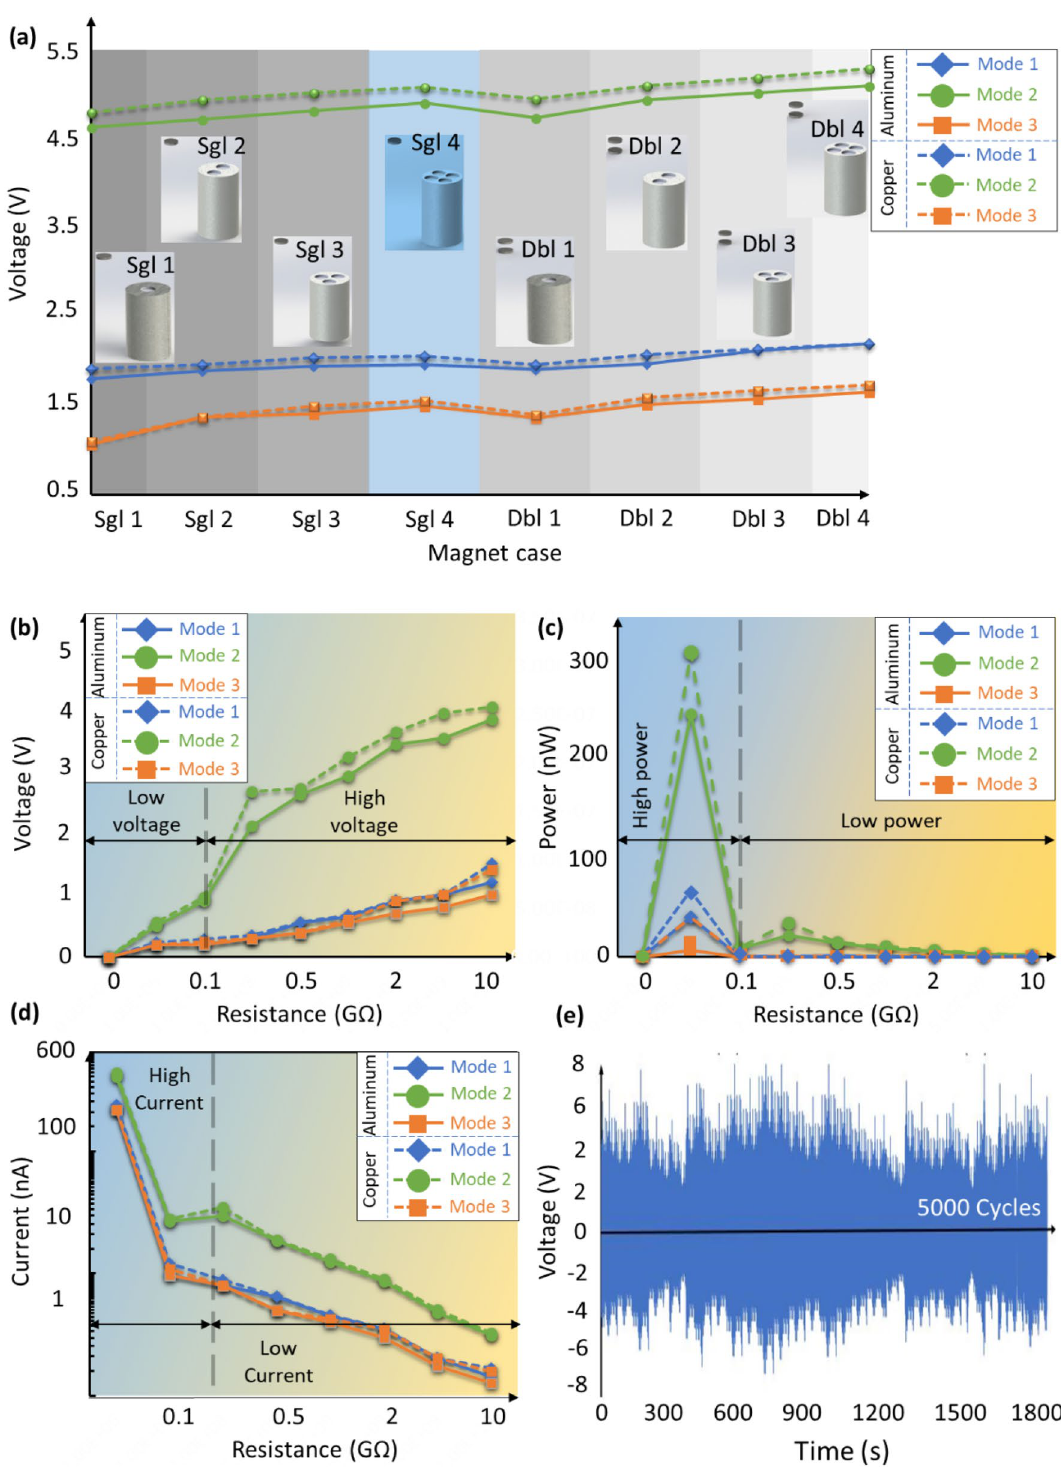
Figure 4. Influences of the end magnets, material and structure on the energy harvesting performance of the MC-TENG. ( a ) Voltage distribution with respect to the end magnets for the copper or aluminum MC-TENG in the open-circuit. ( b ) Voltage ( c ) power and ( d ) current distributions of the MC-TENG in terms of the electrical resistance in the closed-circuit with 4 end magnets on each end (Sgl 4) (all the capsulate TENG are designed in mode 1, mode 2 and mode 3). ( e ) Stability test of MC-TENG under 5000 cyclic loading during